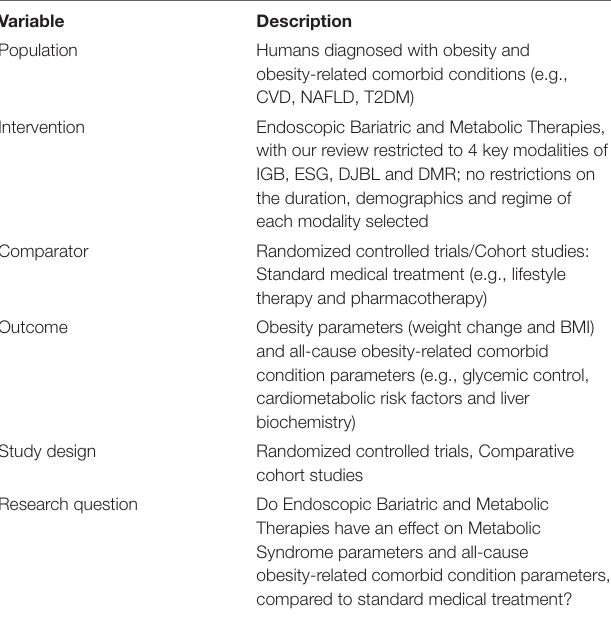
TABLE 1 | Participants, interventions, comparisons, outcomes and study design criteria used to define the research question for this systematic review.